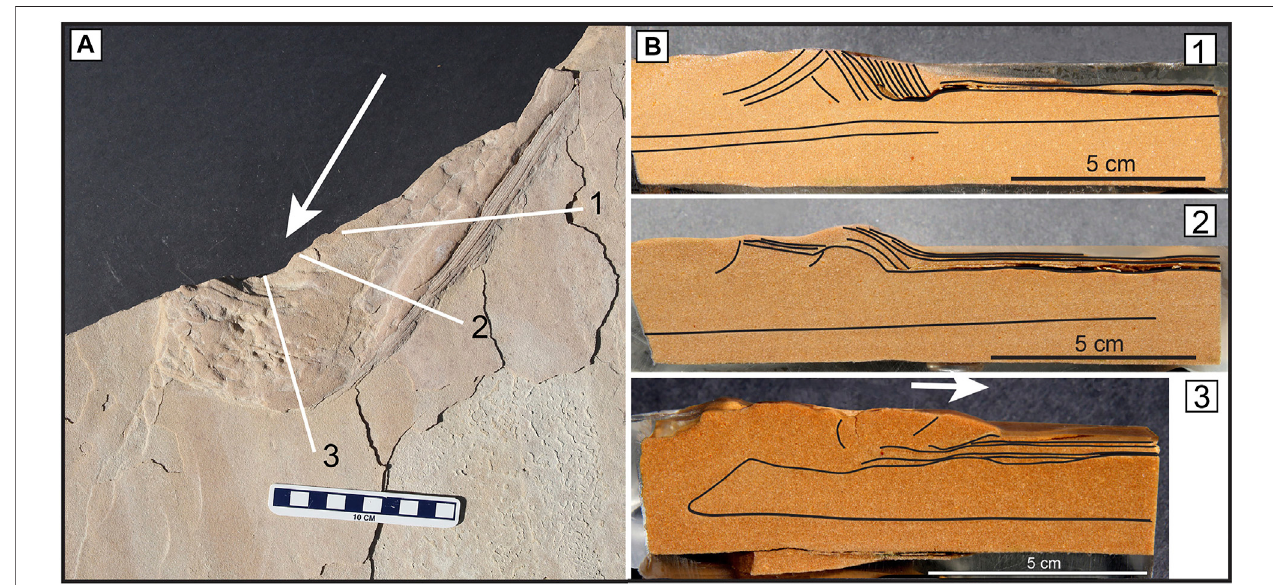
FIGURE5| ASSDSwithcross-sectionalviewsalongthreetransects,asshownbythewhitelinesintheleftphoto.Figures B1-B3 aretransectsalongwhitelines1-3in Figure 5A . Laminae have been highlighted for clarity in the vertical sections B1-B3 , and white arrows show the apparent direction of sand movement during deformation. Scale bar in the left image is 10 cm long.